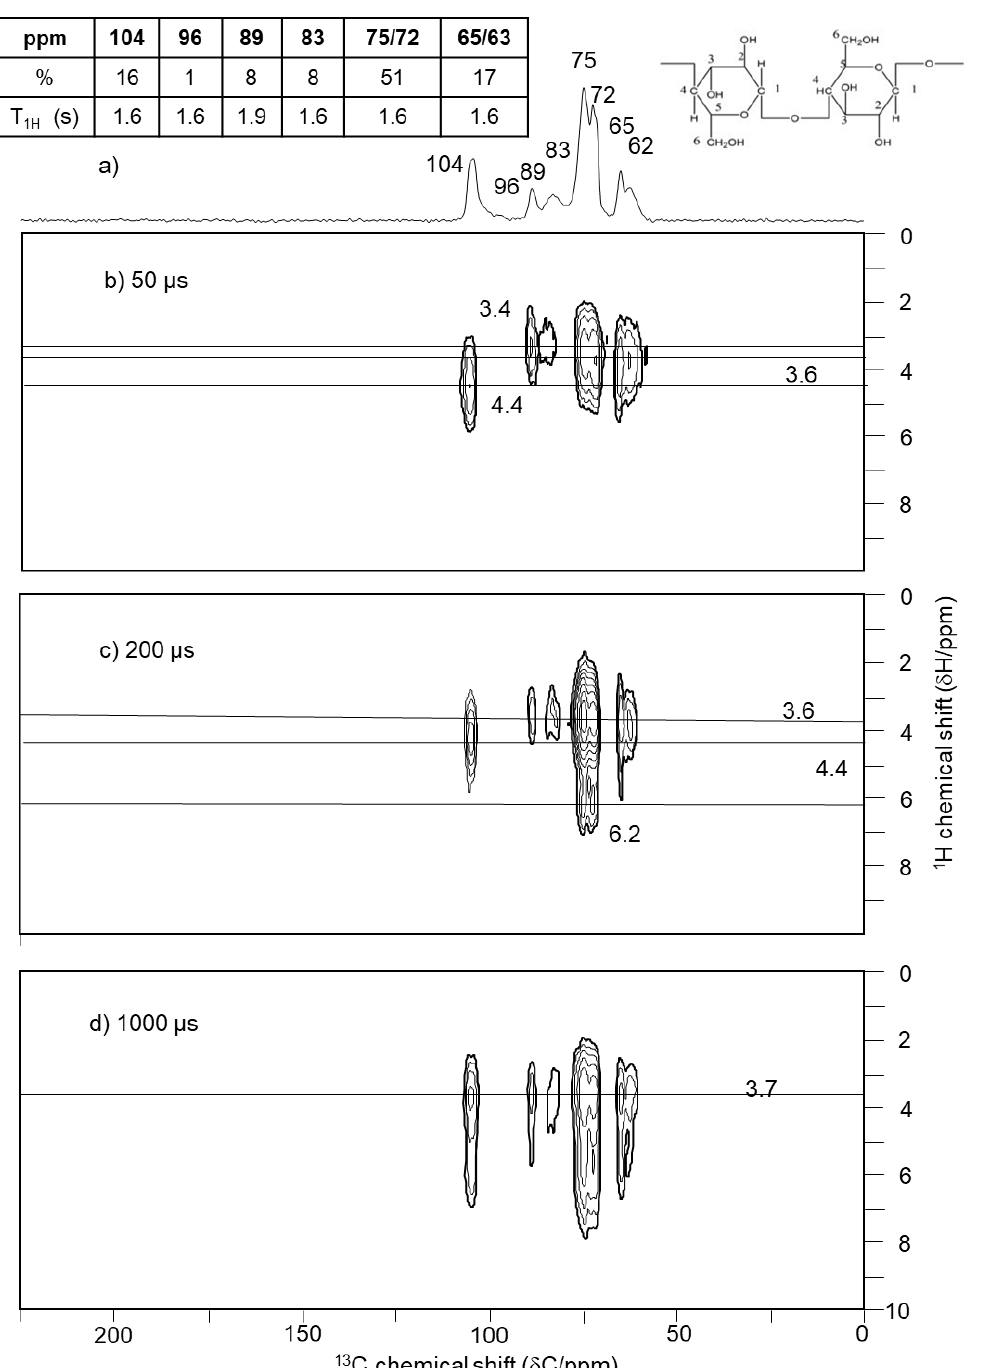
Figure 2. Solid-state 1D 13 C NMR spectrum of α –cellulose, its intensity distribution, the T 1H determined for the respective signal and the chemical structure of cellulose ( a ), the respective 2D 1 H- 13 C HETCOR NMR spectra obtained with a contact time, t c = 50 µ s ( b ), t c = 200 µ s ( c ) and t c = 1000 µ s ( d ).